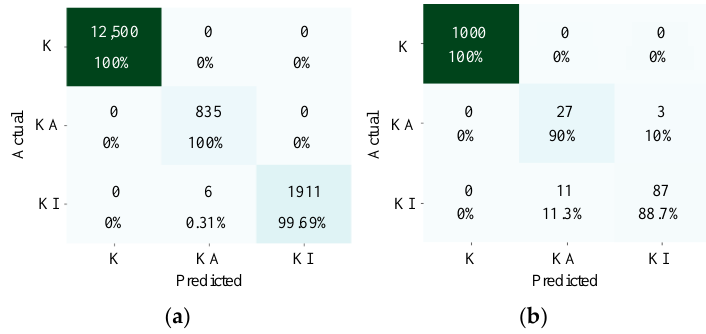
Figure 6. Confusion matrix with ( a ) IFKNMD-CNN and ( b ) IFKNMD-1DCNN.